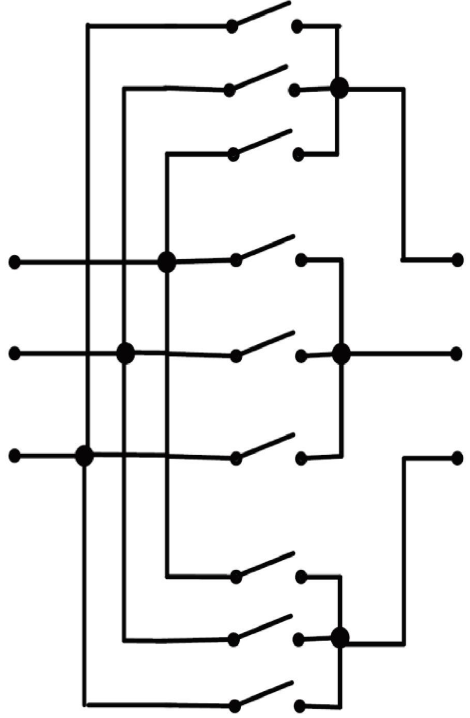
Figure 1: Te general switch arrangement of